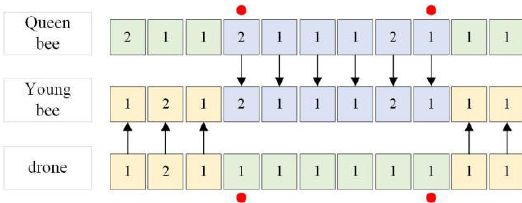
Figure 8. Intersection of machining method layers.